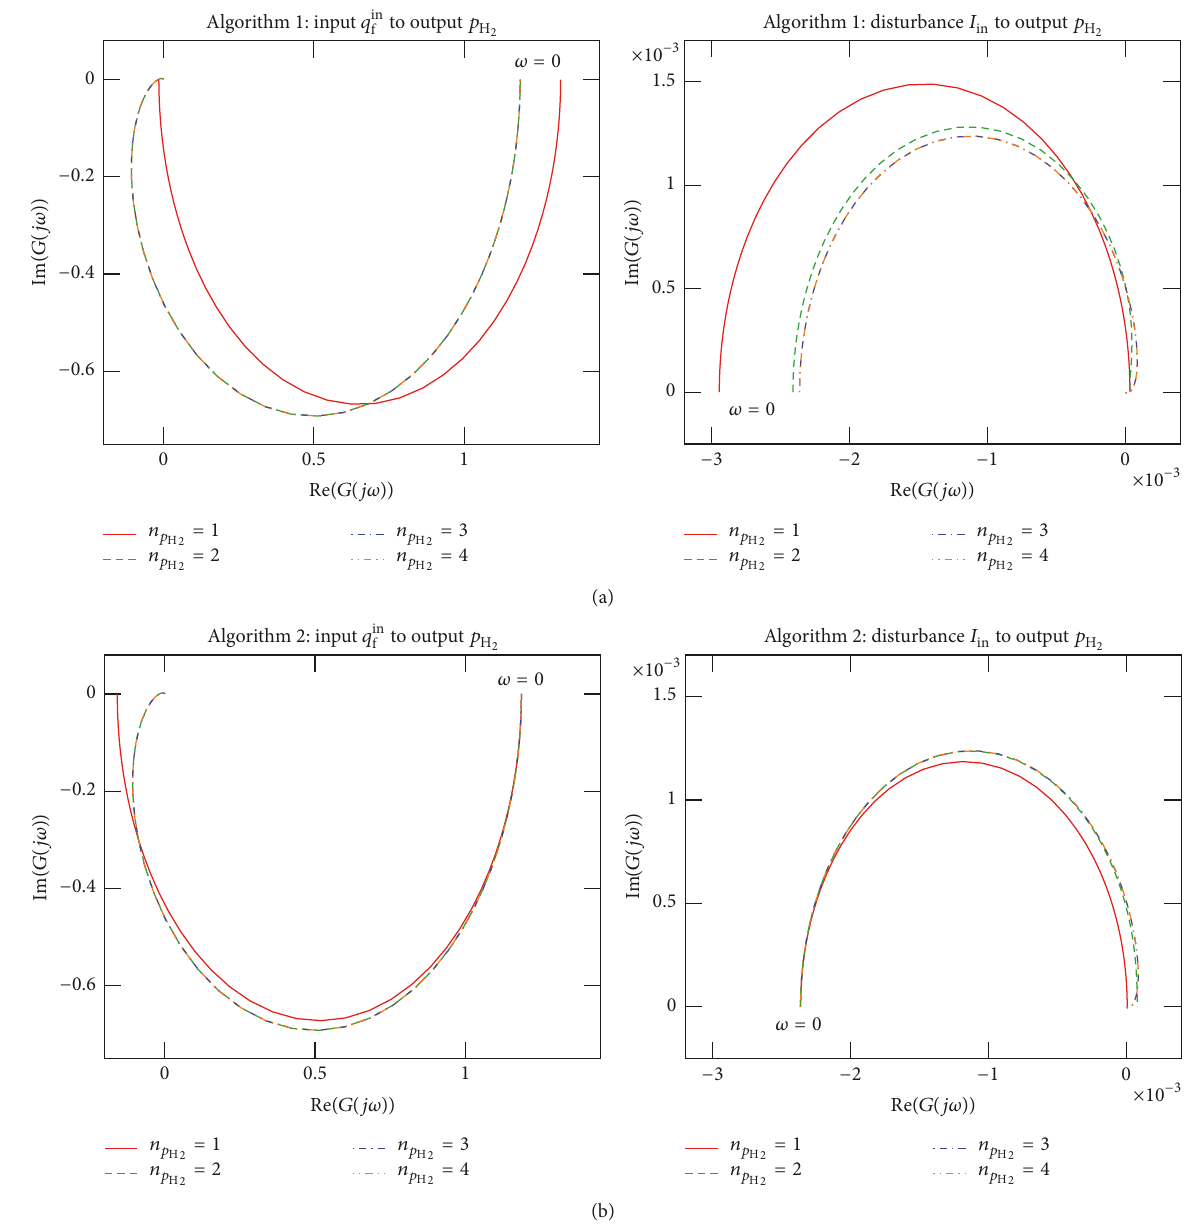
= 1, 2, 3 ) and full order ( 𝑛 = 4 ): reduction algorithm 𝑝 H 2 H 2